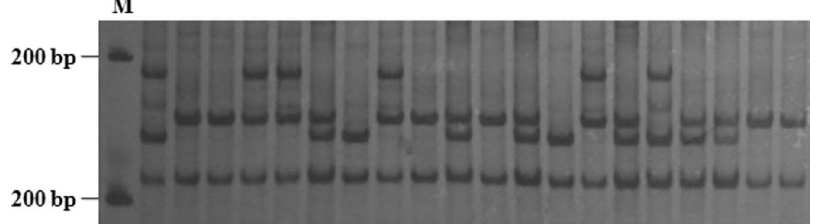
Figure 6. SSR PCR amplification patterns of 20 Callosobruchuschinensis individuals from RD population using primer CCM46. (M is the 100 bp DNA ladder marker).